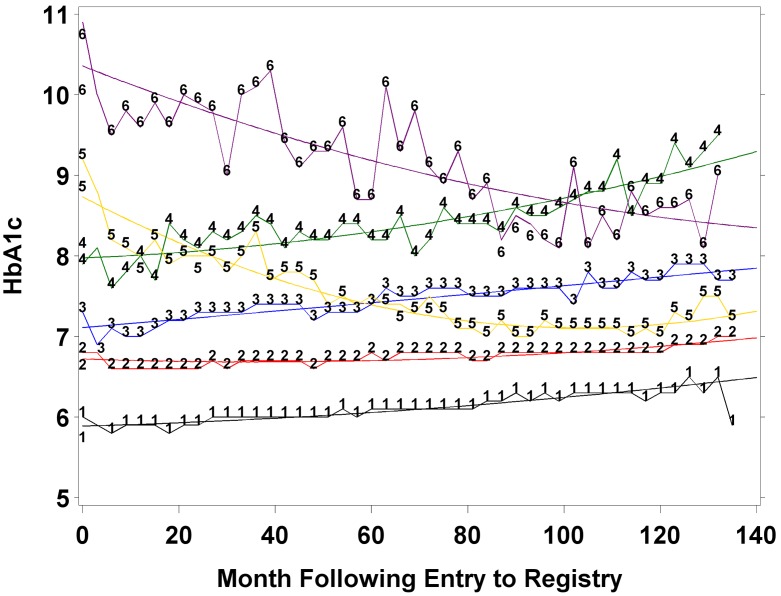
Study flow chart.